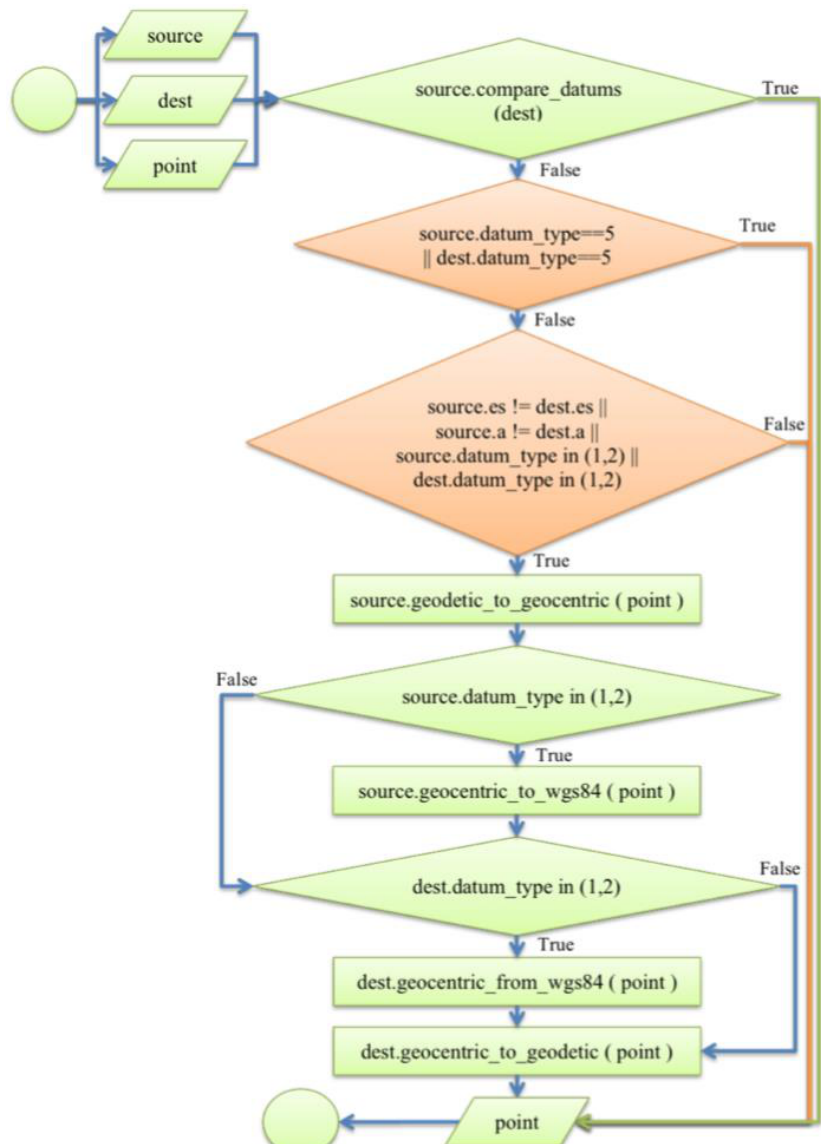
To involve datum transformation in the coordinate transformation, the towgs84 property must be included into the Proj4JS format definition as can be seen in Listing 5. Based on the coordinate transformation algorithm as in Figure 7, if the Proj4JS format definition has towgs84 property then the Proj4JS API transforms each coordinate into WGS84 map projection first before it transforms to the destination of the map projection as illustrated in Figure Figure 9. Determining datum.datum_type Map Projection Property